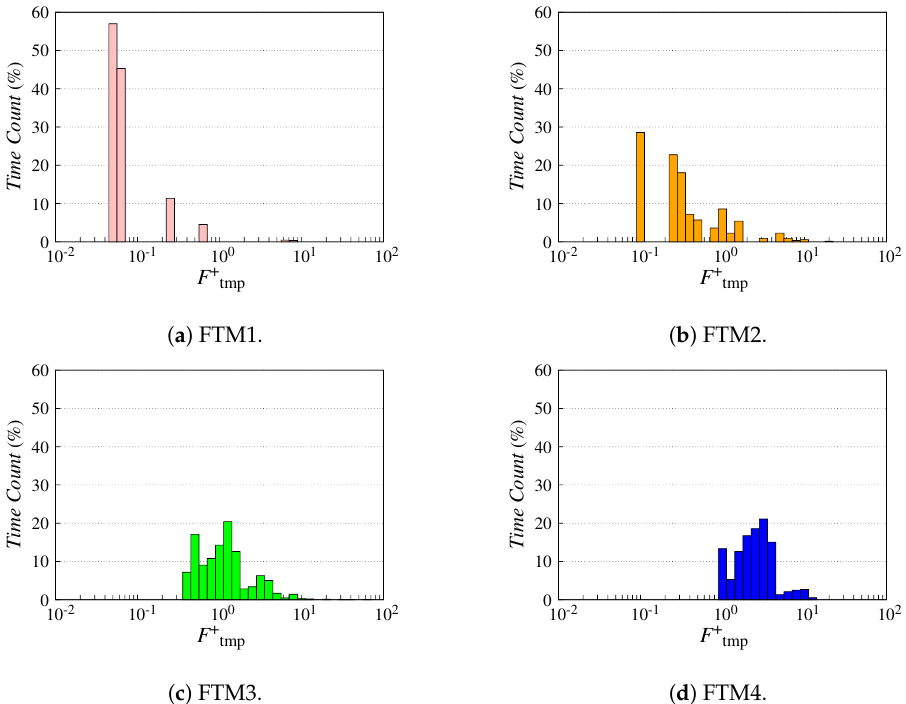
Figure 13. Temporary burst frequency ( F +